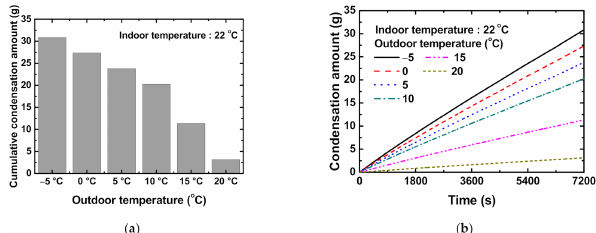
Figure 5. Results of 2 h operation for Case 1: ( a ) cumulative condensation quantity according to outdoor temperature; ( b ) condensation quantity over time.